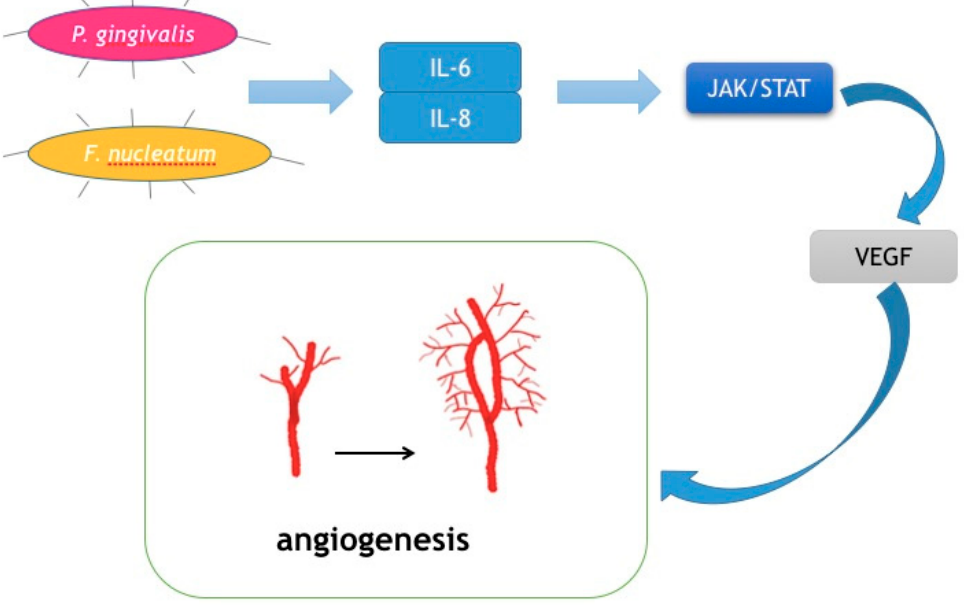
Figure 4. Mechanism for how oral bacteria stimulate angiogenesis.